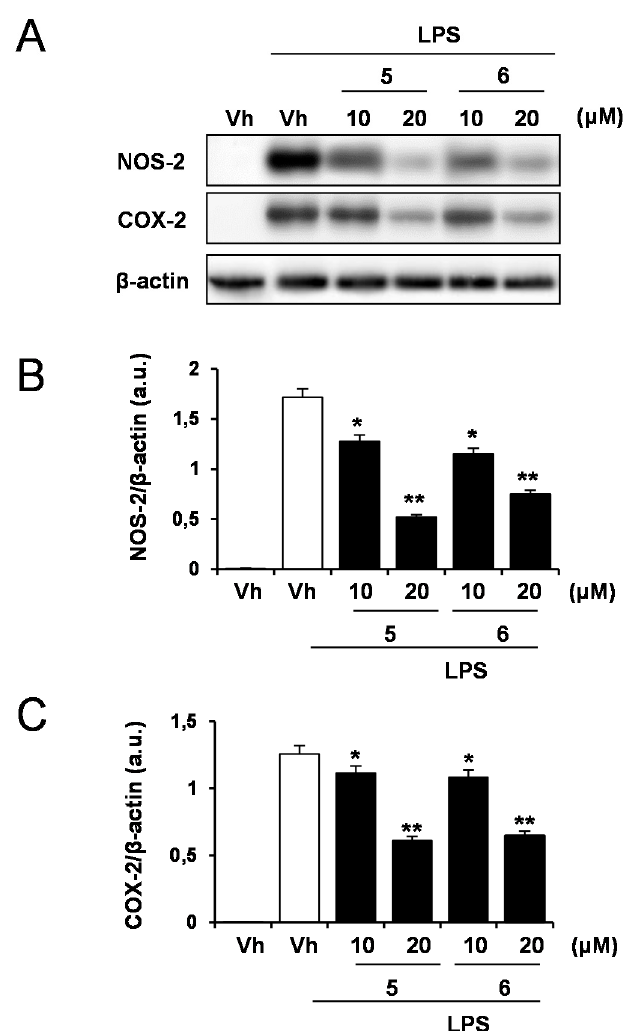
Figure 4. NOS-2 and COX-2 expression is inhibited by solidagenone derivatives. ( A ) Macrophages were preincubated for 30 min with derivatives 5 and 6 (10 and 20 µ M) followed by stimulation with 200 ng/mL LPS for 24 h. NOS-2 and COX-2 proteins were detected by Western blot. β -actin content was used as a loading control. The Western blot in ( A ) shows a representative experiment. ( B – C ) Densitometry analysis of NOS-2 ( B ) and COX-2 ( C ) expression was performed. Results show the mean ± SD of three independent Western blot experiments and are expressed as the percentage of relative signal intensity with respect to the LPS condition. * p < 0.05, ** p < 0.01, with respect to the LPS condition.